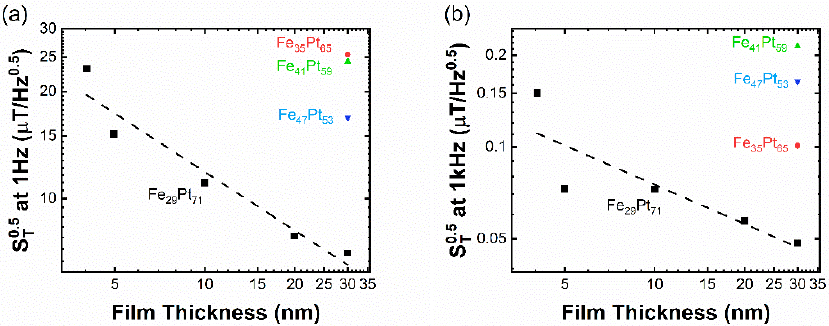
Figure 4. Field detectability of different Fe x Pt 100-x sensors at ( a ) 1 Hz and ( b ) 1 kHz. Both low-frequency and high-frequency detectabilities show the power-law relationship with film thickness, with the exponent close to −0.5.